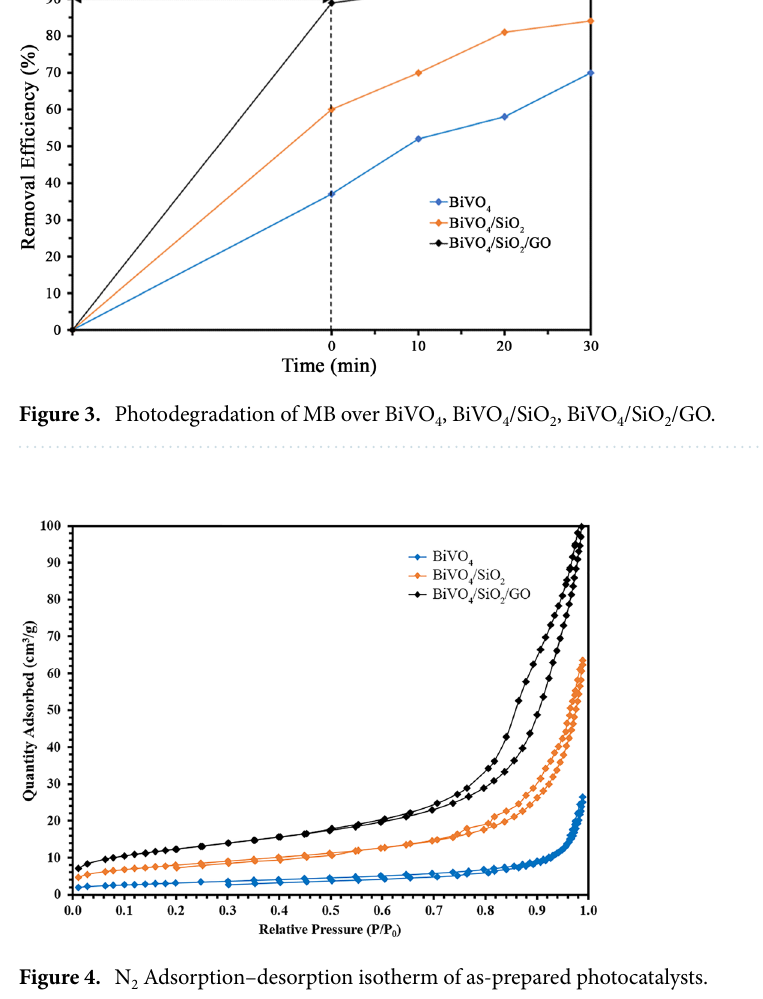
Figure 4. N 2 Adsorption–desorption isotherm of as-prepared photocatalysts.